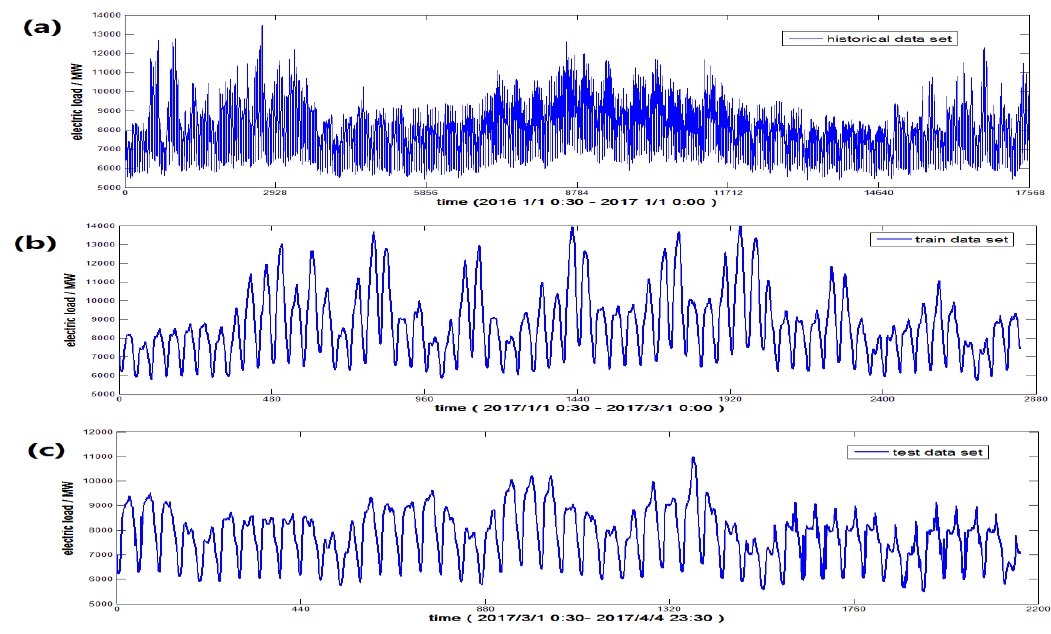
Figure 4. The electric load series of New Souths Wales, ( a ) historical data set; ( b ) train data set; ( c ) test data set.